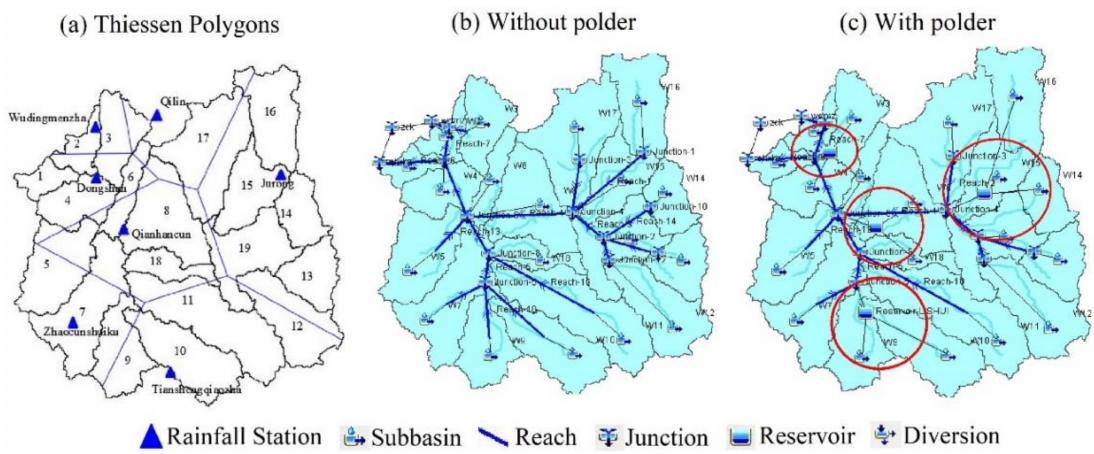
Figure 2. Thiessen polygons of the Qinhuai River basin and HEC-HMS models of the Qinhuai River basin under both with and without polder conditions, ( a ) Thiessen polygons of the Qinhuai River basin, ( b ) HEC-HMS model under without polder condition, ( c ) HEC-HMS model under with polder